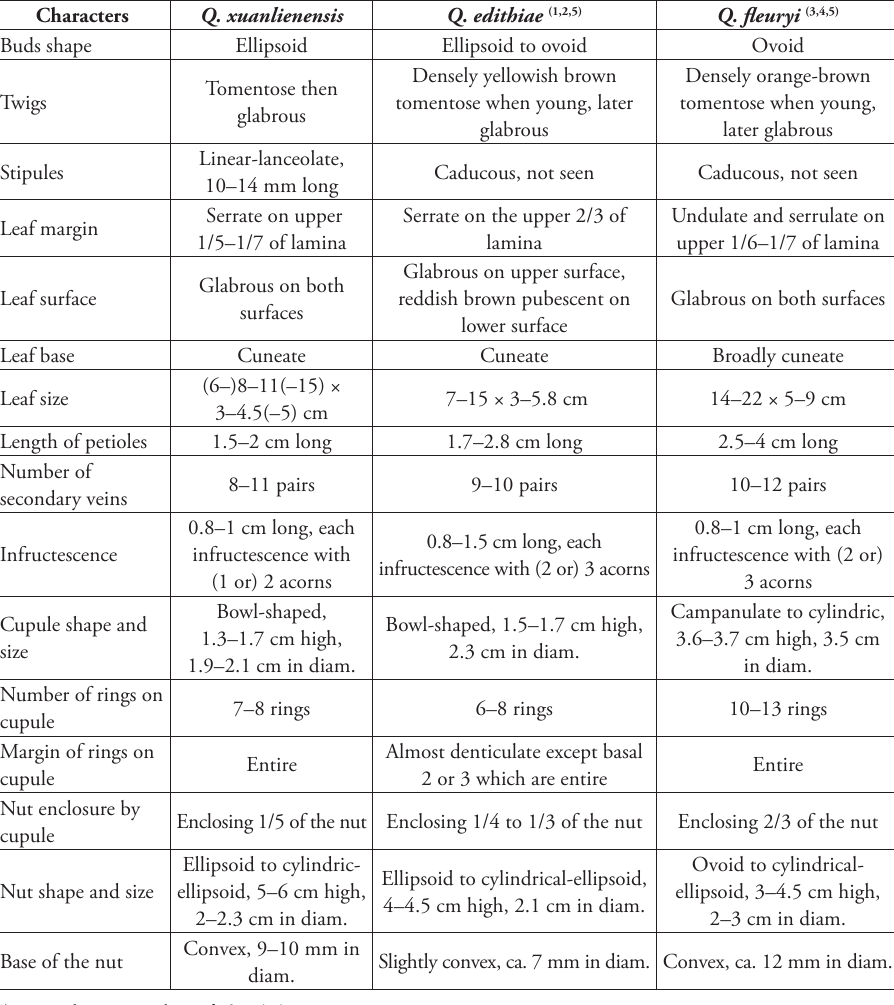
Table 1. Morphological comparison amongst Quercus xuanlienensis Binh, Ngoc & Bon, sp. nov., Quercus edithiae Skan and Quercus fleuryi Hickel & A.